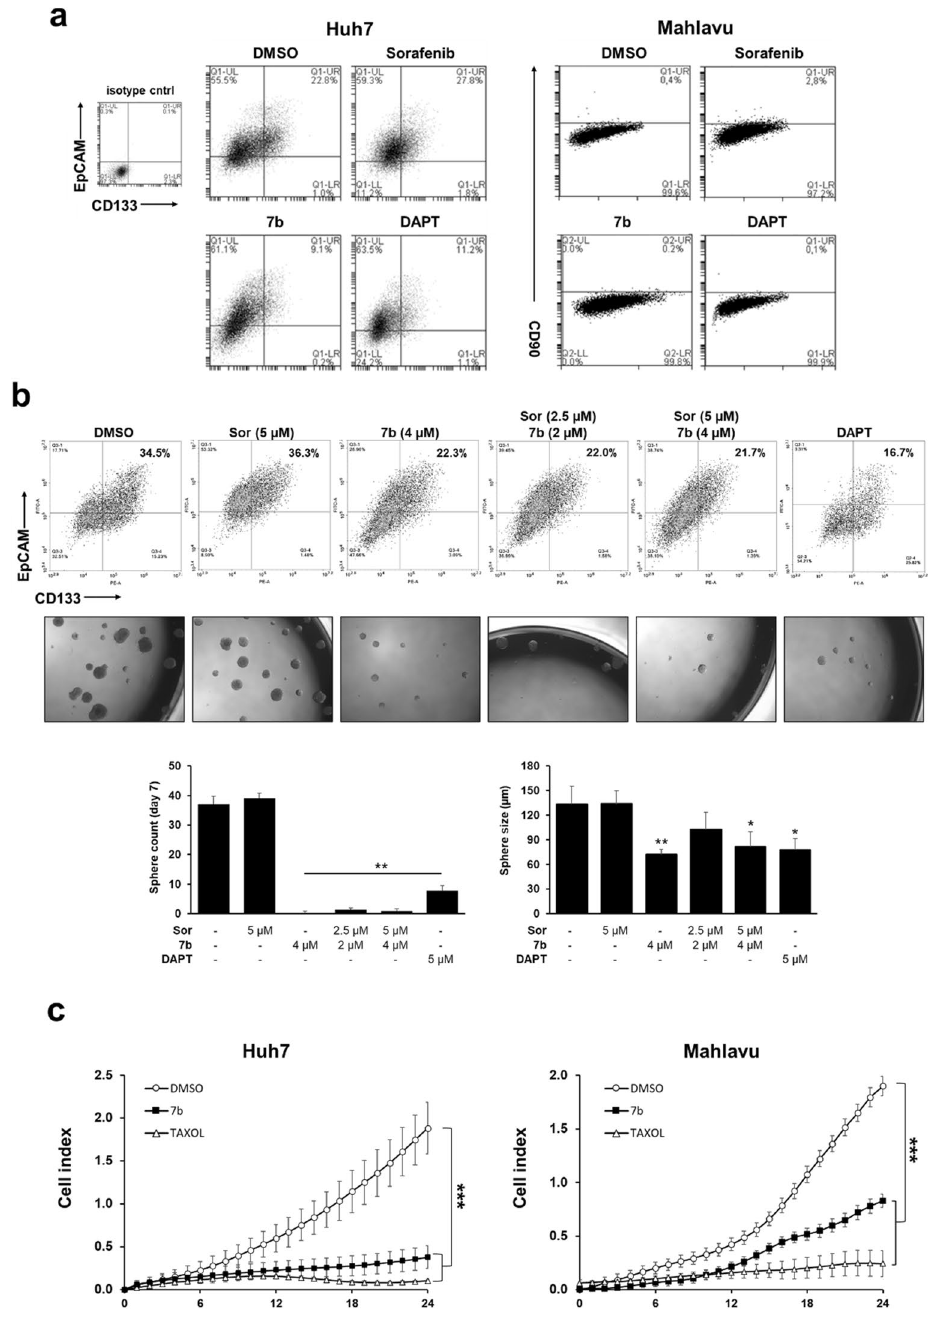
Figure 7. 7b reduces enrichment of LCSCs and the migration capacity of HCC cells . Huh7 and Mahlavu cells were treated with sorafenib (5 µM), DAPT (5 µM), compound 7b (2 µM), or DMSO control for 72 h. ( a ) Images represent flow cytometric analysis of CD133/EpCAM positivity in Huh7 cells, and CD90 positivity in Mahlavu cells upon treatment with indicated compounds/inhibitors. Upper-right quadrant (UR): double-positive cells for CD133 and EpCAM for Huh7 cells; upper-window: positivity for CD90 for Mahlavu cells. ( b ) Flow cytometric analysis of CD133/EpCAM positivity in Huh7 cells treated with compound 7b or sorafenib alone and with combinations of compound 7b and sorafenib and representative images of spheres formed by Huh7 cells. Bar graphs indicate quantitative analysis of sphere count and diameter in different treatment groups. ( c ) Cell migration index of Huh7 and Mahlavu cells treated with the positive control, taxol (20 ng/ml) or compound 7b (2 µM for Huh7 and 3 µM for Mahlavu) for 24